Question: Produce a descriptive caption suitable for publication.
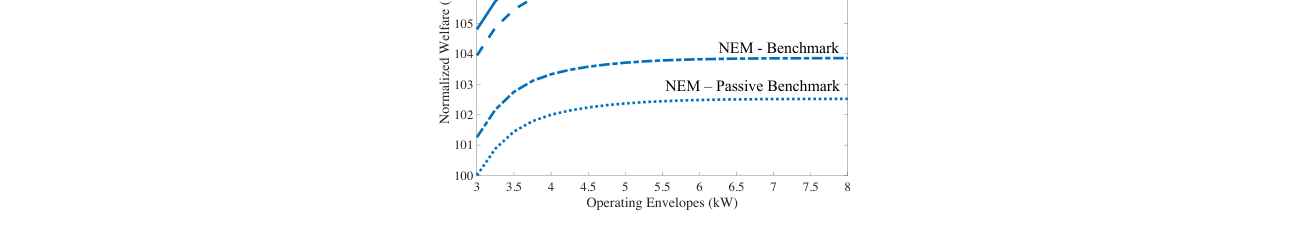
Answer: Normalized average monthly welfare (%) under varying OEs.